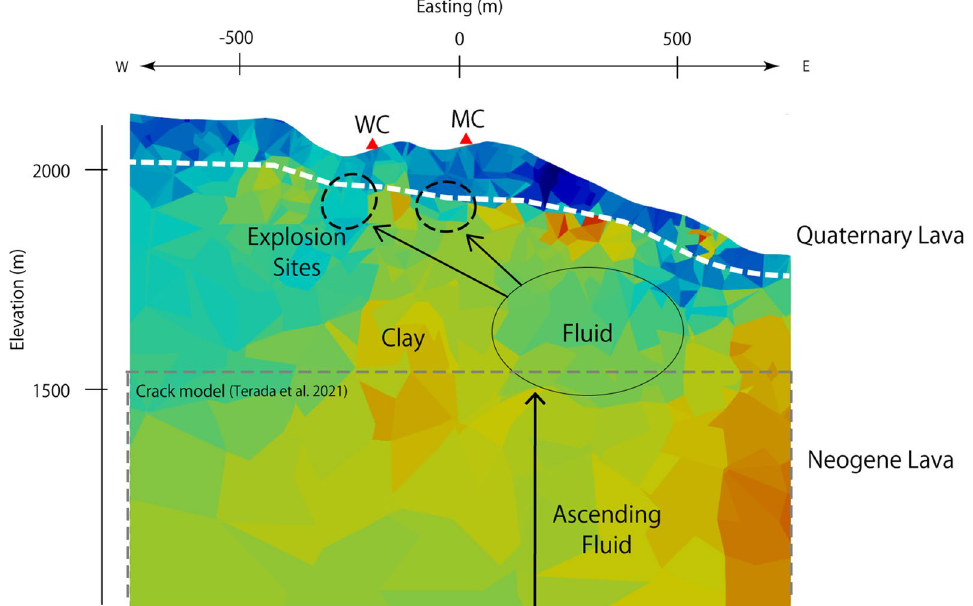
Fig. 10 Schematic model of the shallow hydrothermal system of Mt. Motoshirane related to the 2018 eruption based on the E-W cross section of the 3-D resistivity structure shown in Fig. 8. The white dashed line represents the boundary of the basement rock. Black arrows show the movement of fluids. Gray dotted line represents the crack model proposed by Terada et al. (2021). Note that the crack model is approximately parallel to this resistivity cross-section